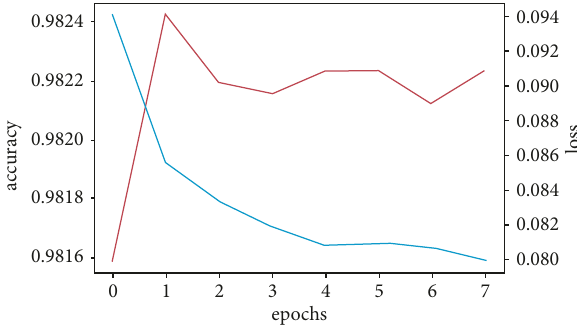
Figure 14: CNN model four accuracy and Table 5: Our CNN models and their accuracy.